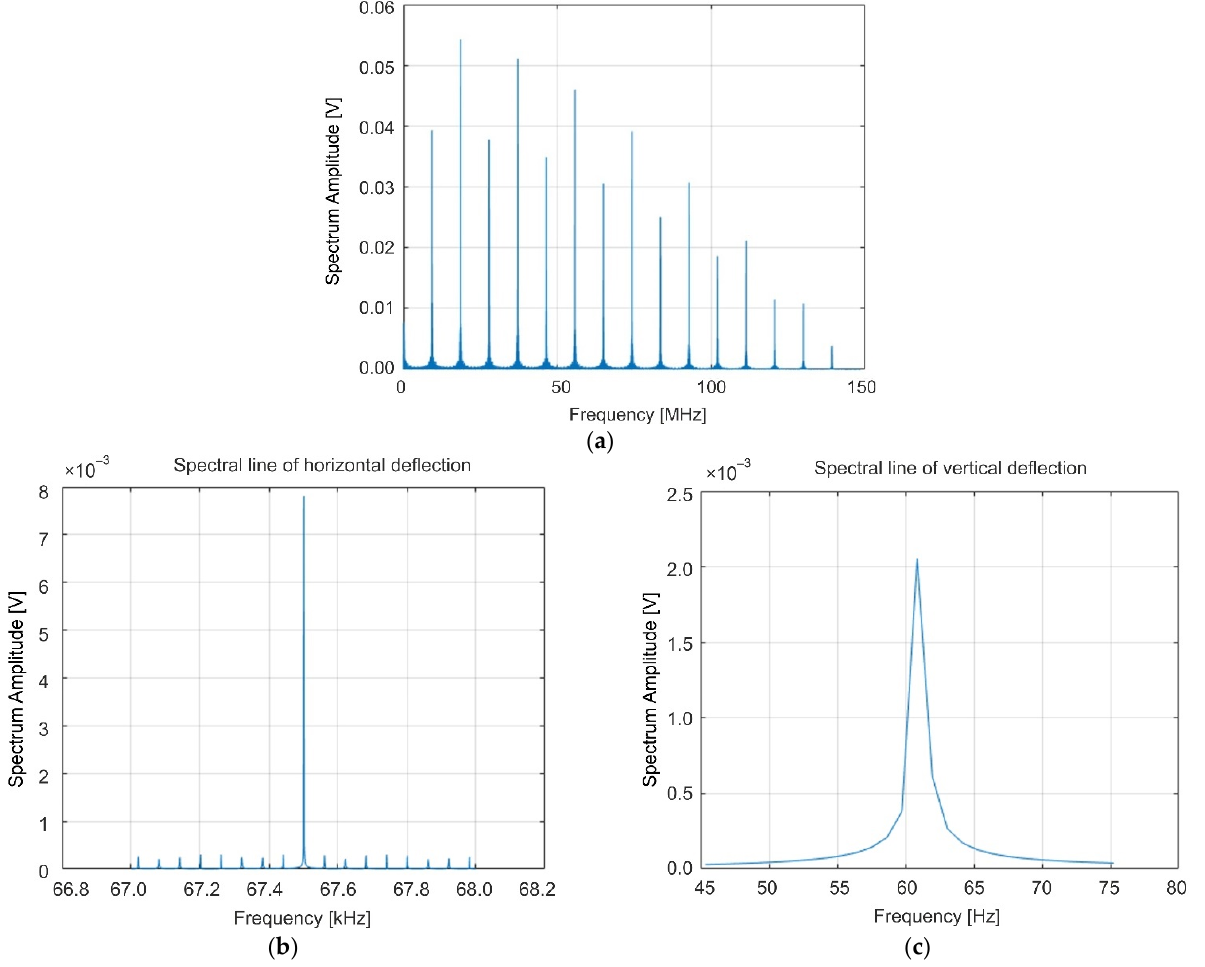
Figure 3. ( a ) Amplitude spectrum of the test signal (strips 8 × 8) and magnification of its fragments corresponding to the ( b ) horizontal and ( c ) vertical sync frequencies.